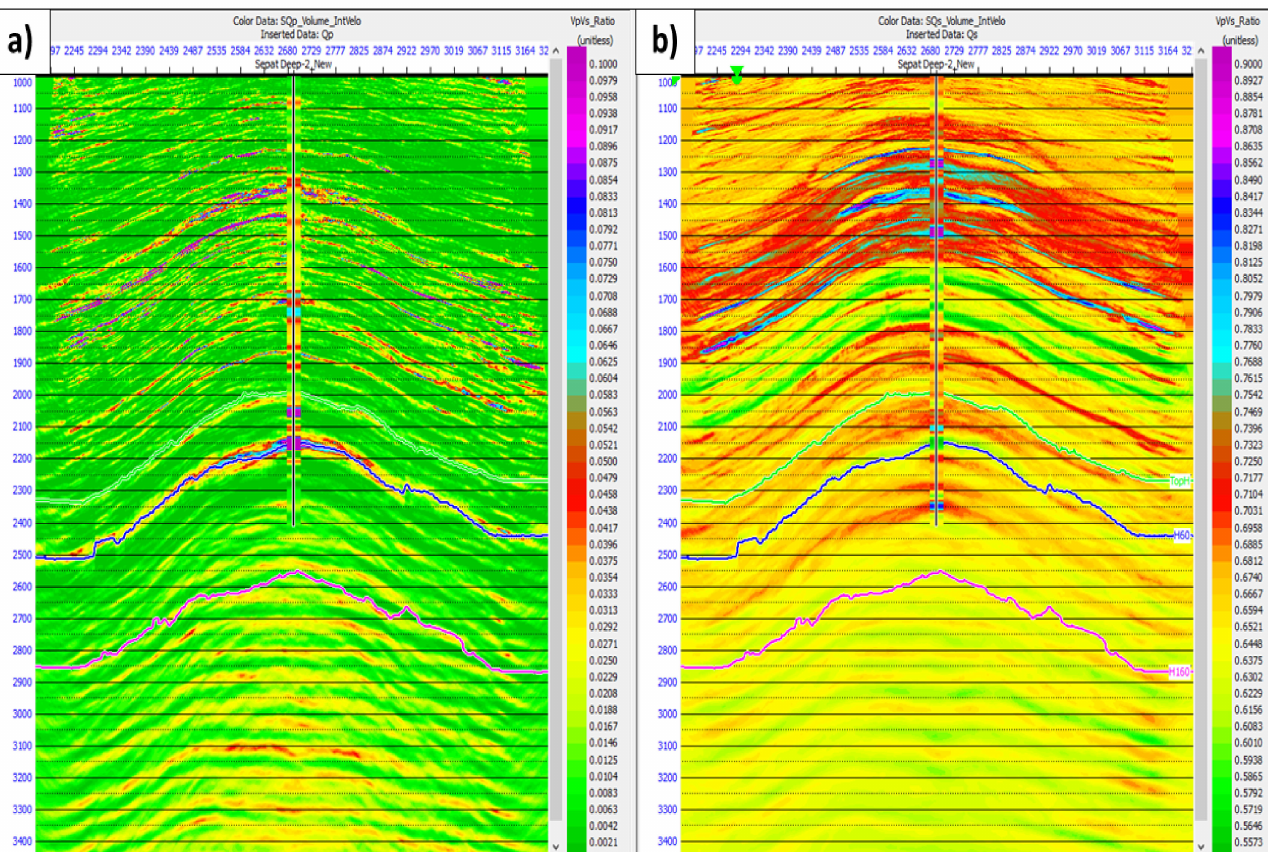
Figure 21. ( a ) Inverted SQp crossline section containing XD-2 well; ( b ) Inverted SQs crossline section containing XD-2 well. Figure 22a,b show the distribution and changes of SQp and SQs attributes’ values within the interval between Top H and H60 horizons. The SQp attributes delineated the distribution of sand (green colour) and shale (violet colour) lithology. The area of interest (dotted line in Figure 22a) responded as a low value of the SQp attribute, indicating the presence of sand lithology. The dotted line in Figure 22b exhibited a high SQs value, indicating the sand porosity is filled by hydrocarbons. From the horizon slices generated at Top H to H 60 horizons of the study area, it can be summarised that the west of the study area is sand-prone and filled by